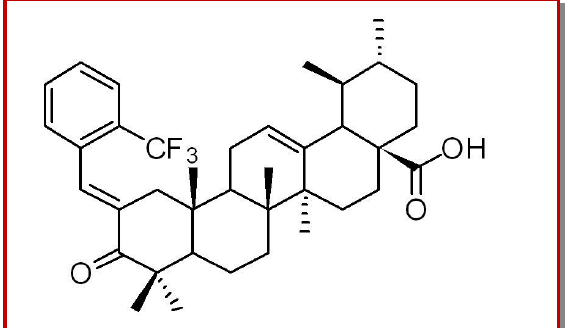
Figure1: Structure of ursolic acid benzaldehyde